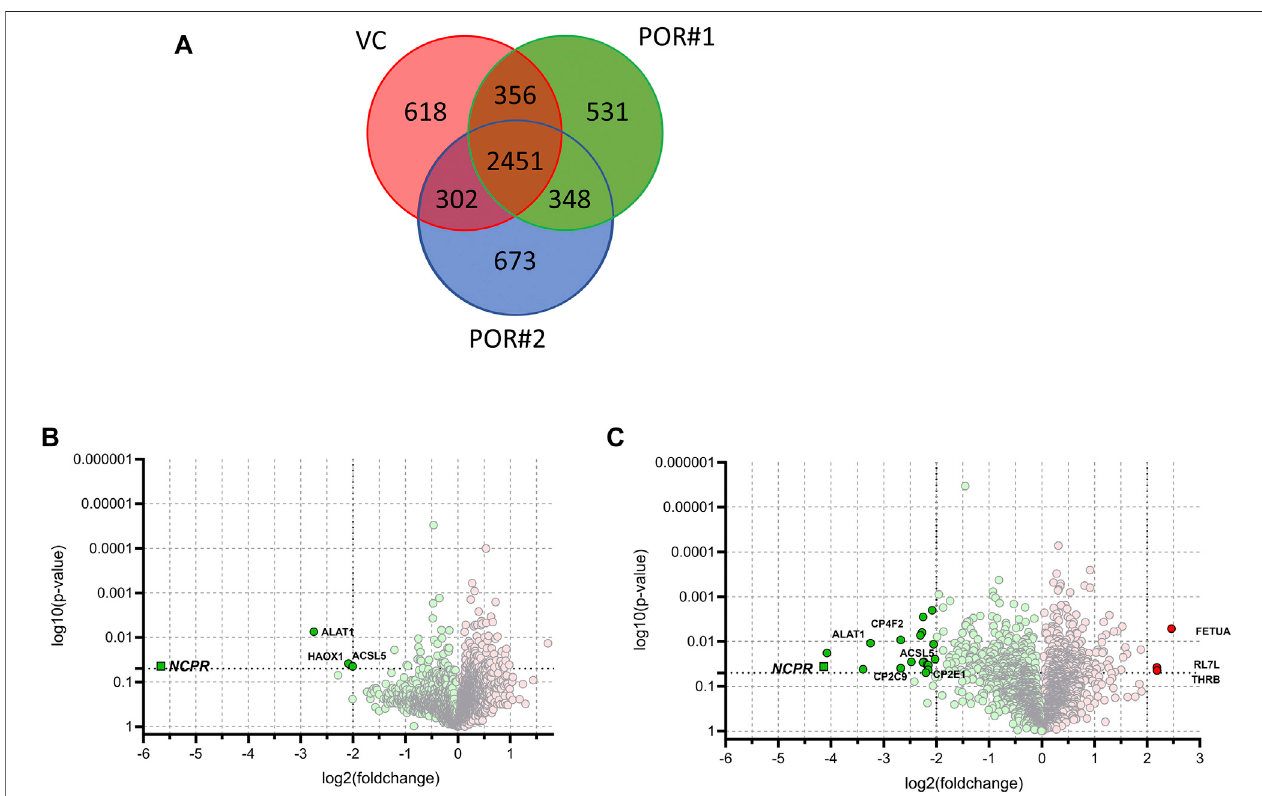
FIGURE 4 | Results of label-free quantitative proteomics of HepaRG cells transduced with sgRNAs POR#1 and POR#2 and vector control (VC) (A): Venn diagram showing the unique and common proteins identi fi ed in HepaRG VC , HepaRG − POR cells. Volcano plots representing statistical comparison of HepaRG − POR#1 (B) and HepaRG − POR#2 (C)cells toHepaRG VC .Two-groups t -test p -valuesaregivenon the y -axis withthe corresponding log2 (fold changes) ofprotein intensities onthe x -axis, respectively (green: lower expressed, red: higher expressed). Statistically signi fi cant proteins with p ≤ 0.05 and log2 (fold change) ≥ 2 are highlighted and selected proteins are labelled with protein